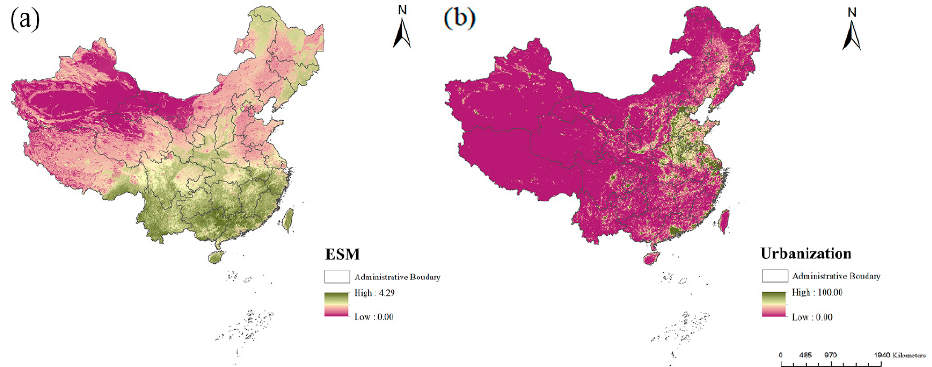
Figure 3. Spatial distribution of the ecosystem service multifunctionality (ESM) ( a ) and urbanization ( b ) in 2020.